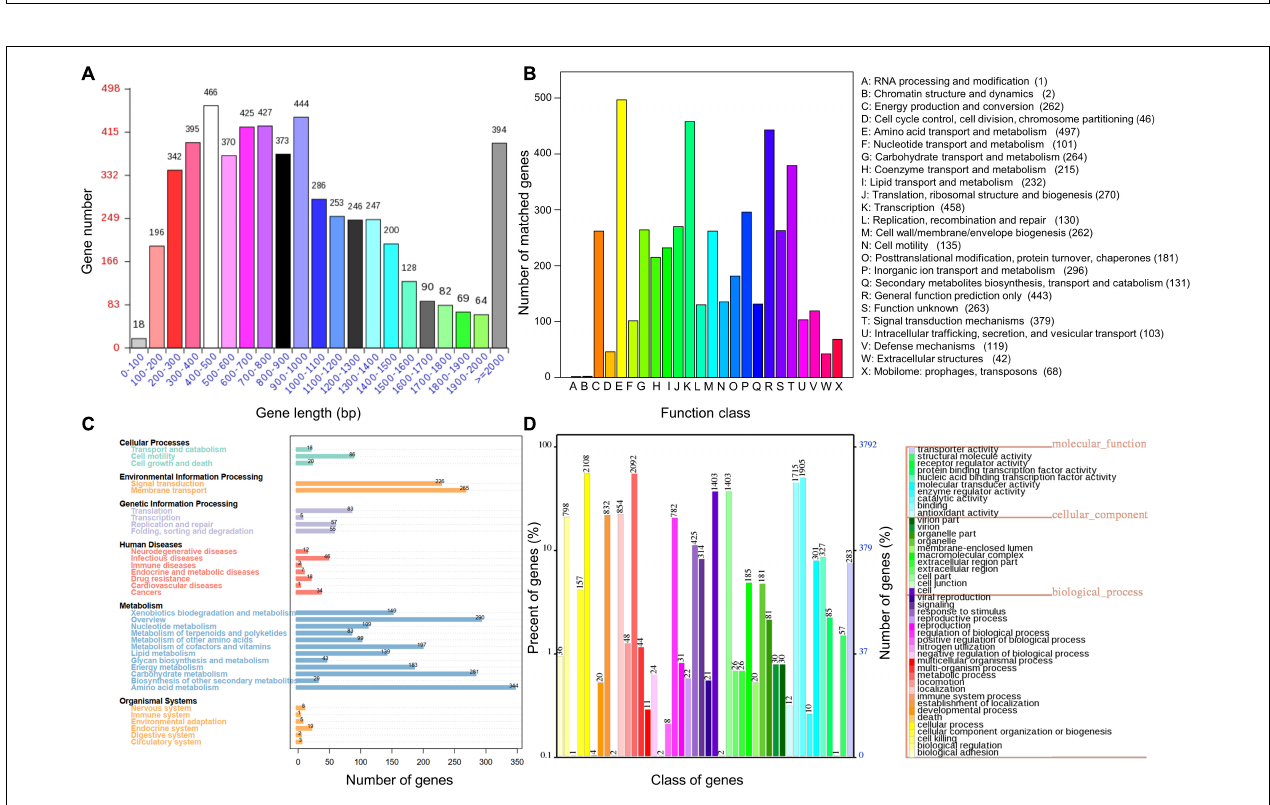
FIGURE 2 | Genome phylogenetic tree based on the whole genome sequences of PF08 and some Pseudomonas strains compared in the study.